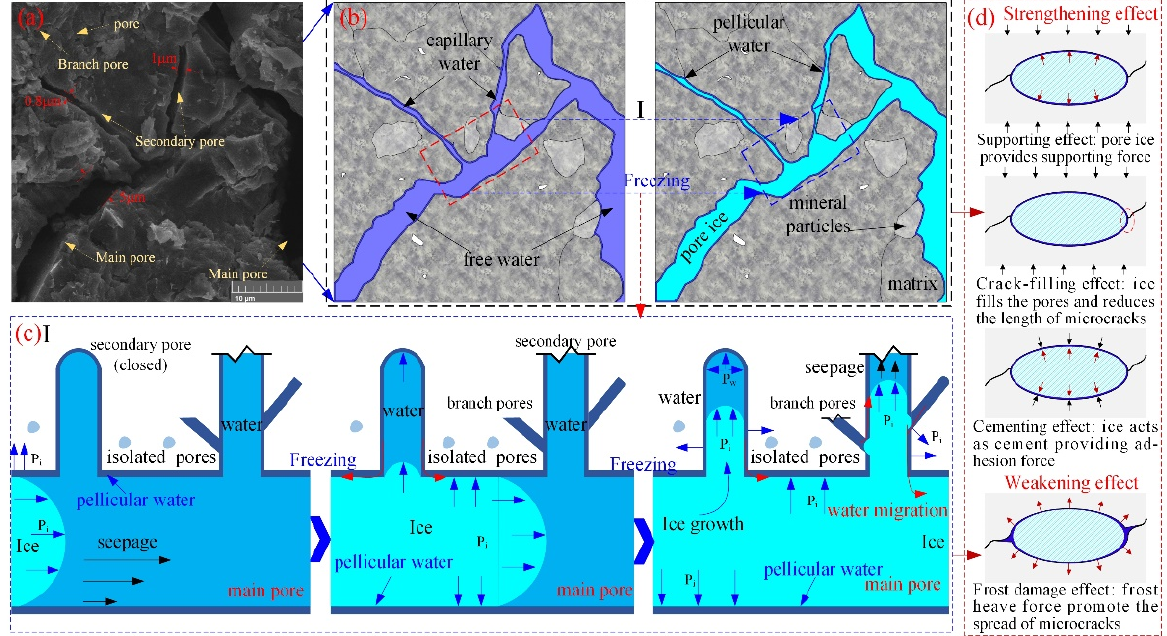
Figure 18. Expansion behavior and influence mechanism of pore ice during sandstone freezing: ( a ) SEM image; ( b ) abstracted pore structure model; ( c ) freezing process; ( d ) pore ice effects.